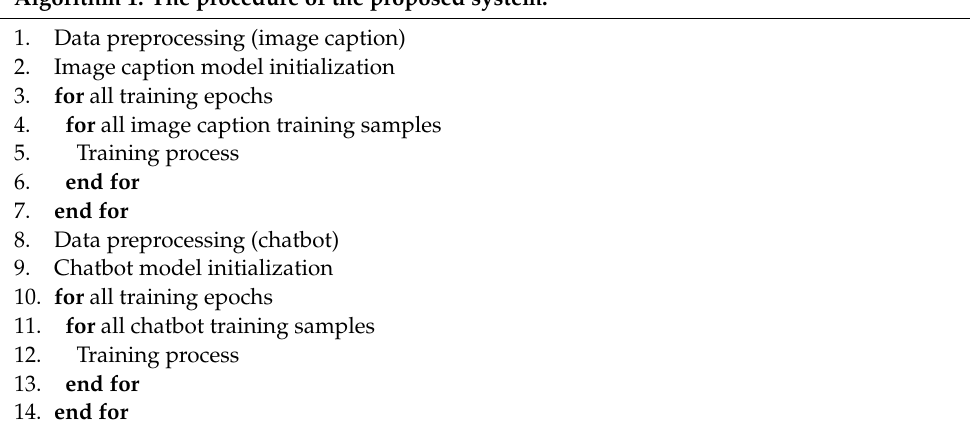
Figure 9. System flowchart of the training process.